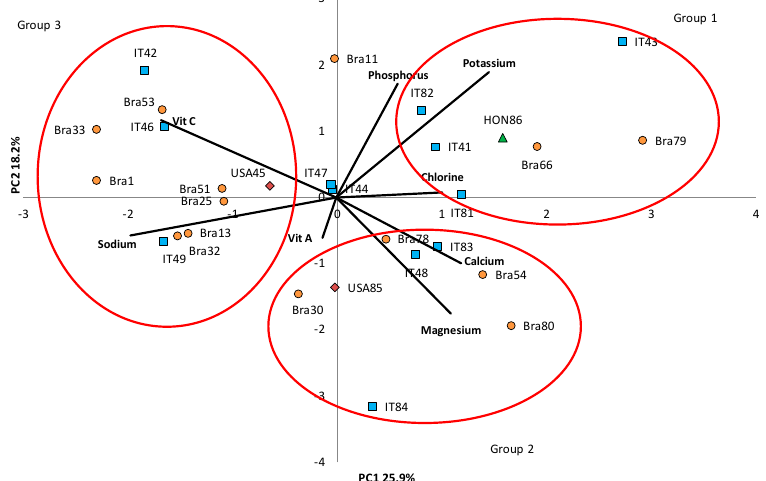
Figure 2. Principal components analysis (PCA) of the sweet potato core collection based on qualitative traits and their contribution to the daily nutritional intake according to adults’ needs (European Food Safety Agency standards). Genotypes origin: Honduras; United States; Brazil.